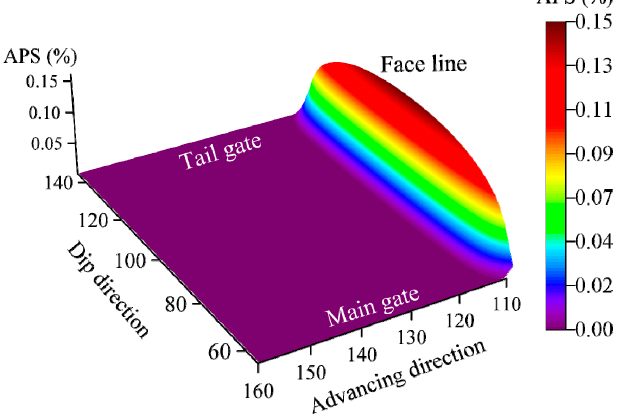
Figure 15. Distribution of APS on the measuring plane.